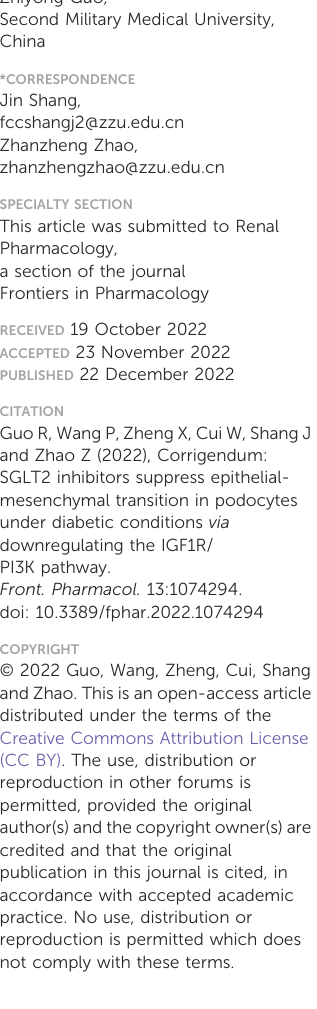
Figure 3B, and Figure 4 as